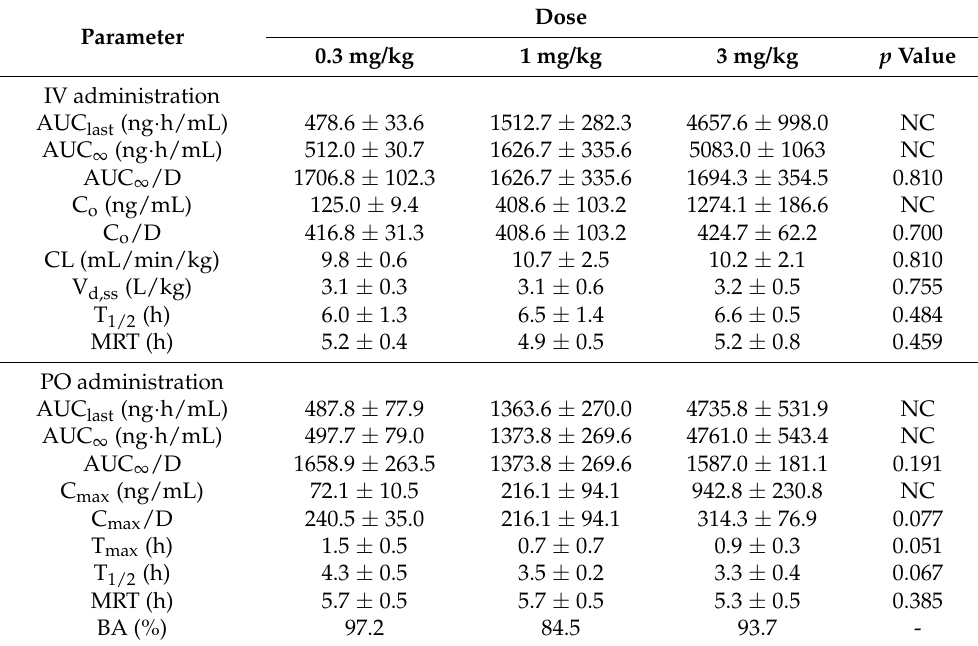
Table 2. Dose-independent pharmacokinetic parameters of enavogliflozin after intravenous and oral administrations of enavogliflozin in